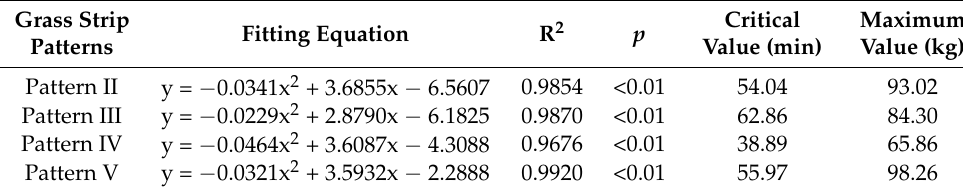
Table 1. Fitting equations of average accumulation amount of soil loss reduction with respect to scouring duration under different grass strip patterns.